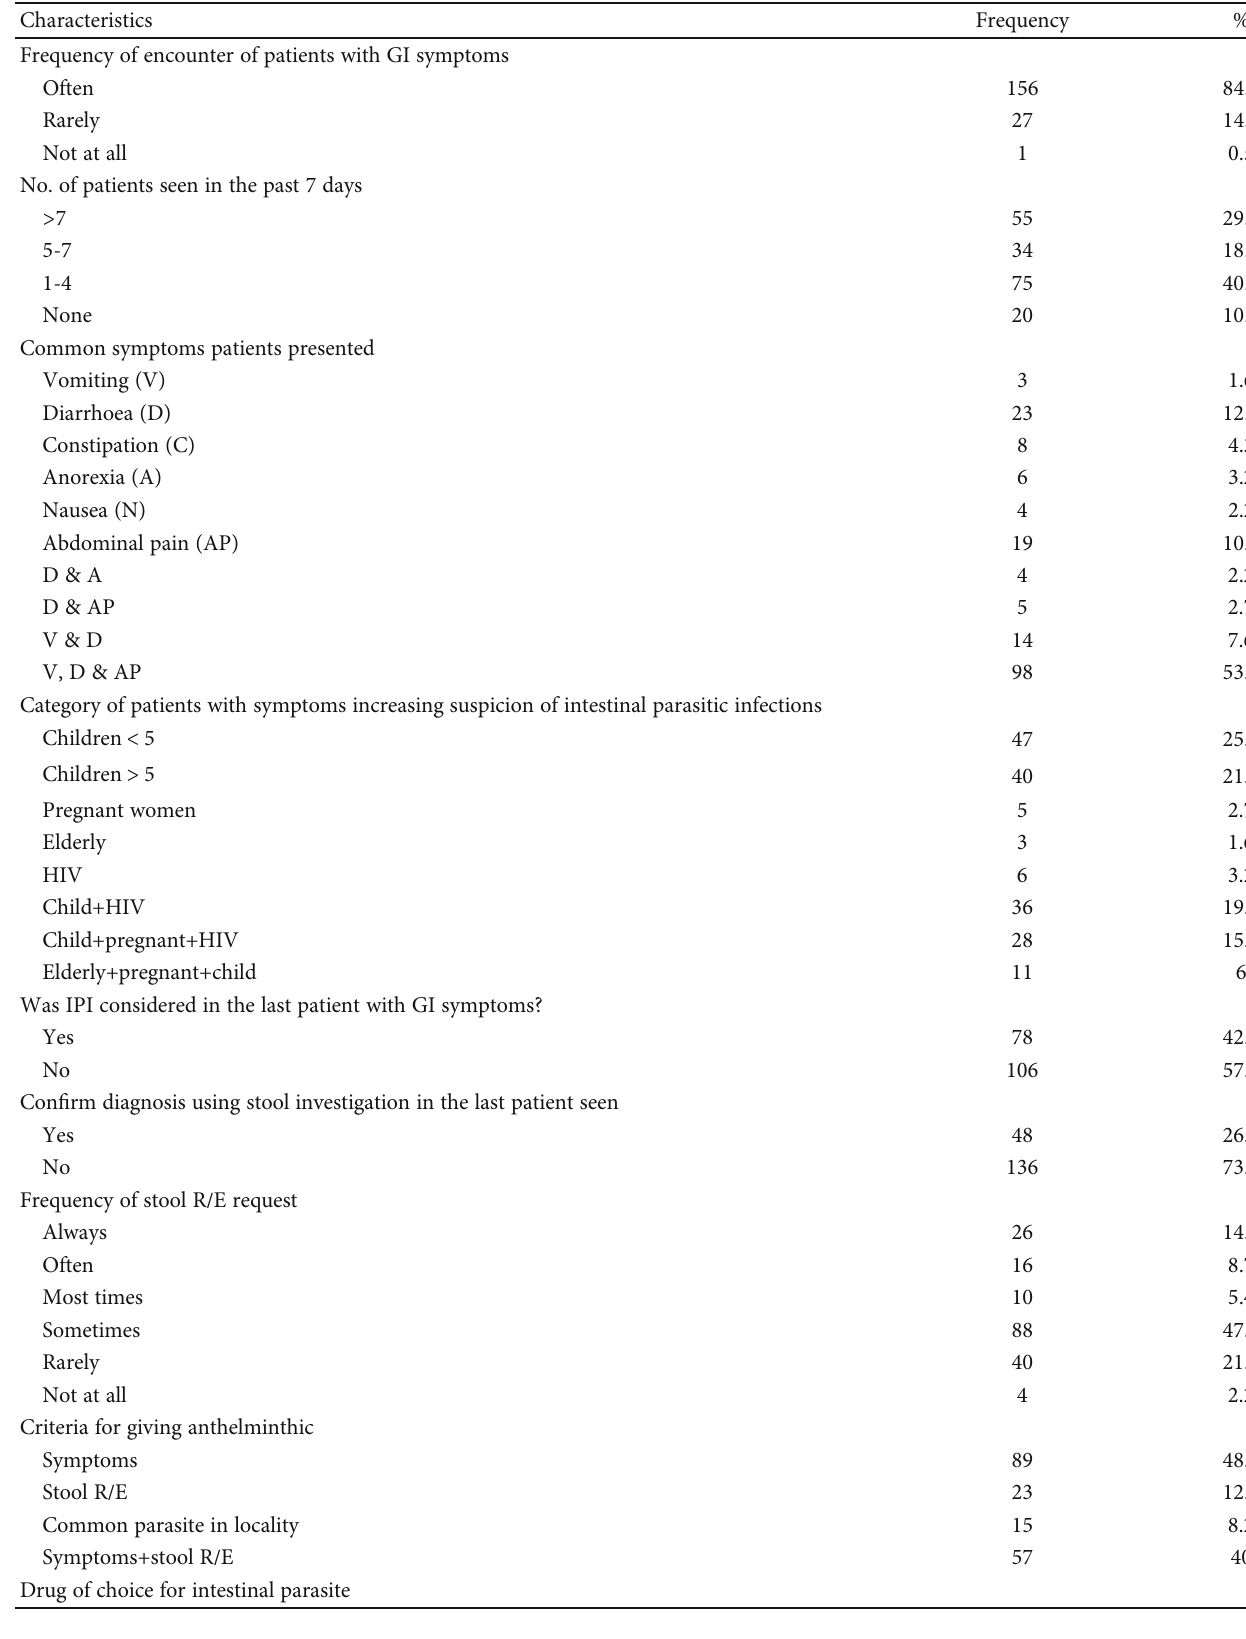
Table 2: Characteristics of clinical practice of